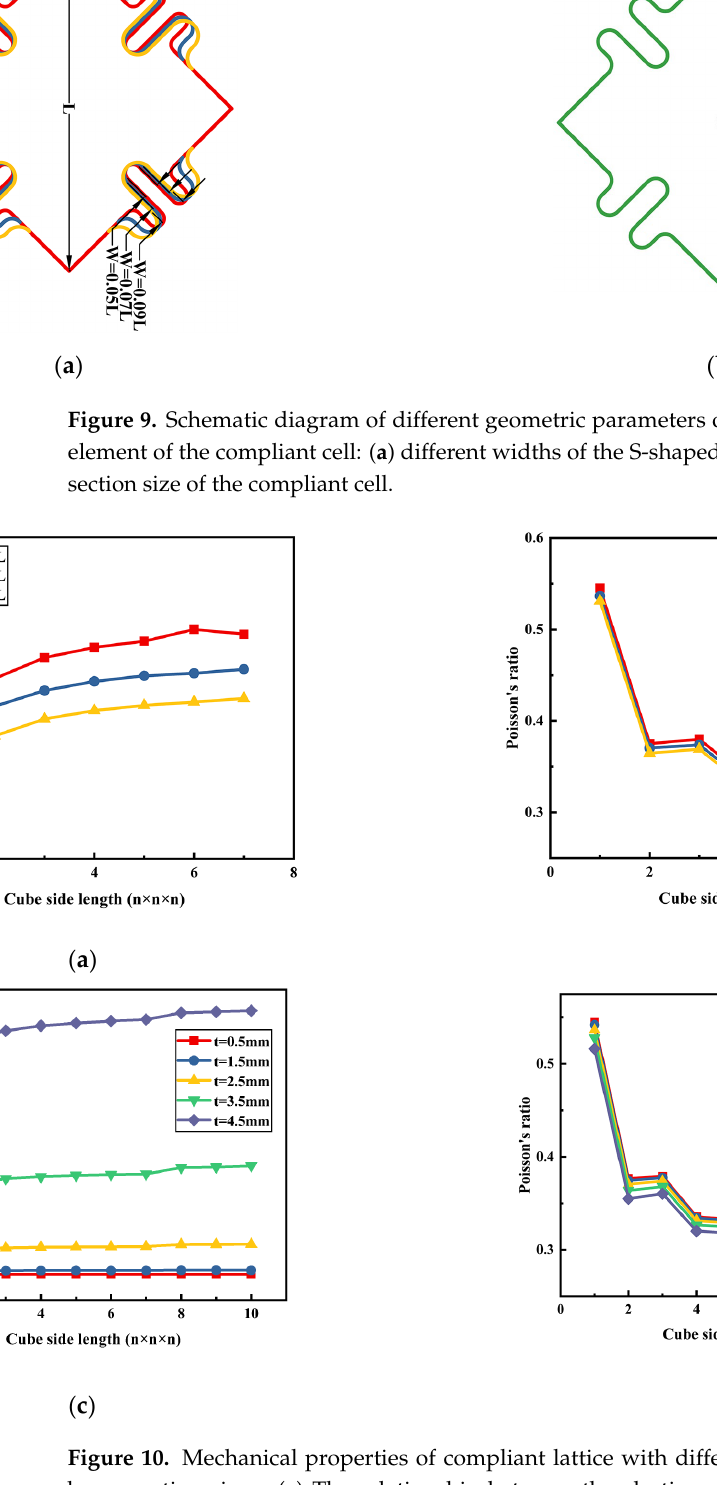
Figure 10. Mechanical properties of compliant lattice with different S-shaped bulge widths and beam section sizes: ( a ) The relationship between the elastic modulus and the cube side length (W = 0.05–0.09 L); ( b ) The relationship between the Poisson’s ratio and the cube side length (W = 0.05–0.09 L); ( c ) The relationship between the elastic modulus and the cube side length (t = 0.5–4.5 mm); and ( d ) The relationship between the Poisson’s ratio and the cube side length (t = 0.5–4.5 mm).